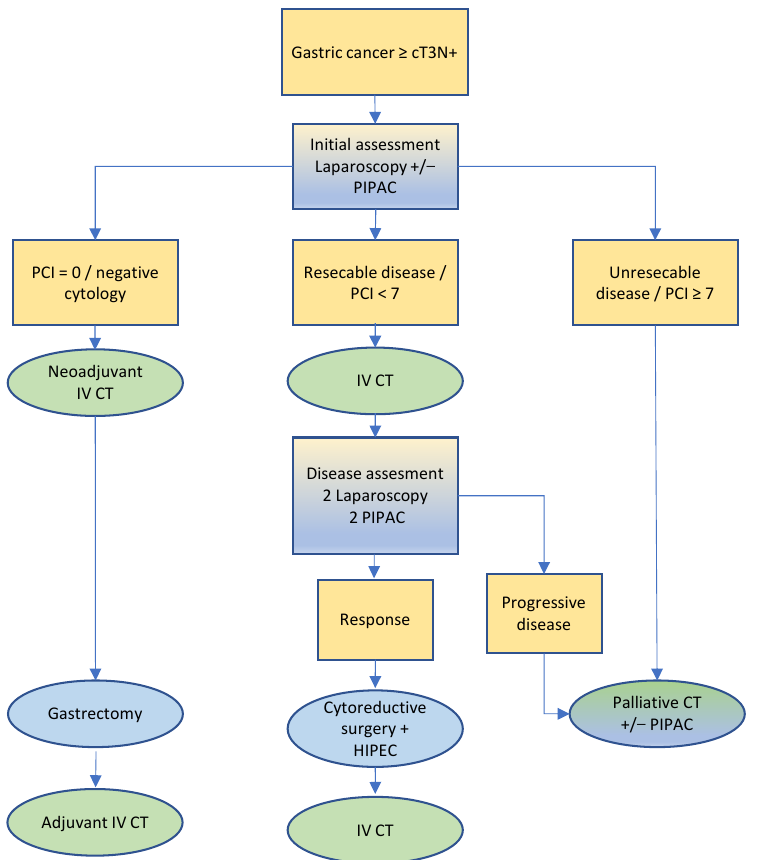
Figure 3. Treatment algorithm for gastric